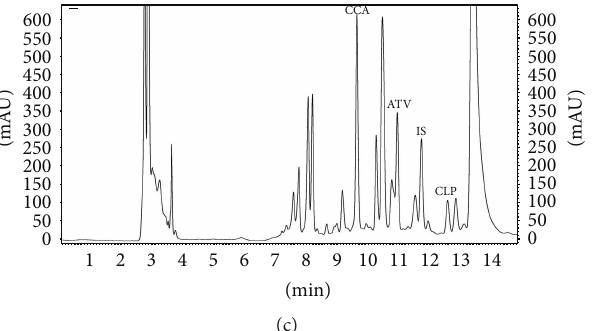
= 10.998 min), IS-ibuprofen (2 𝜇 g ⋅ Ml −1 , 𝑡 𝑅